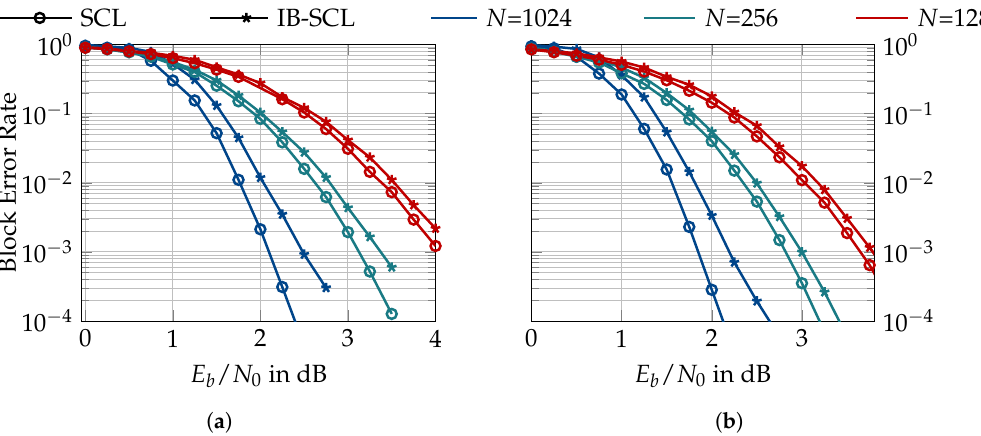
Figure 21. Block error rate of conventional (SCL) and a 4-bit information bottleneck (IB-SCL) decoders for N = 1024,256 and 128, rate 0.5, 16-bit CRC design E b / N 0 = 3 dB. ( a ) N L = 8, ( b ) N L = 32.